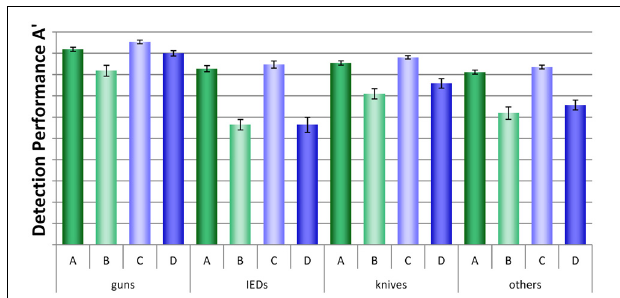
FIGURE 5 | Mean detection performance A’ with standard errors of the mean for all four conditions (A–D) and each threat category (guns, IEDs, knives, others).